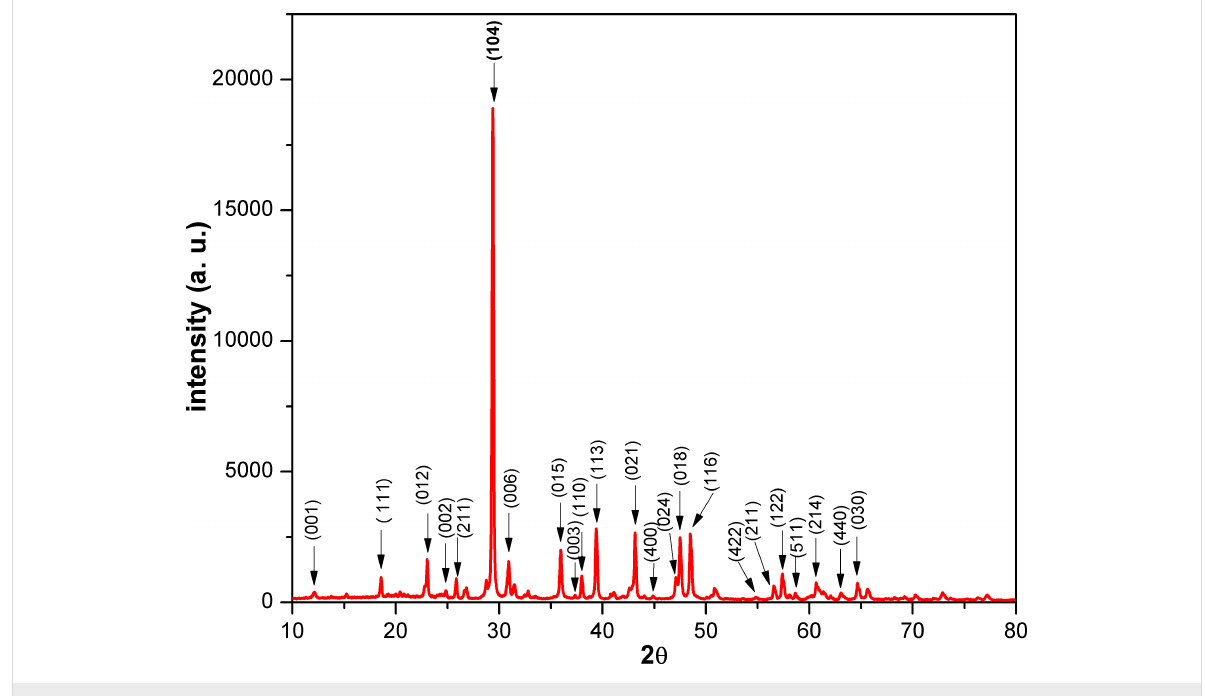
Figure 2: XRD pattern of the NDL